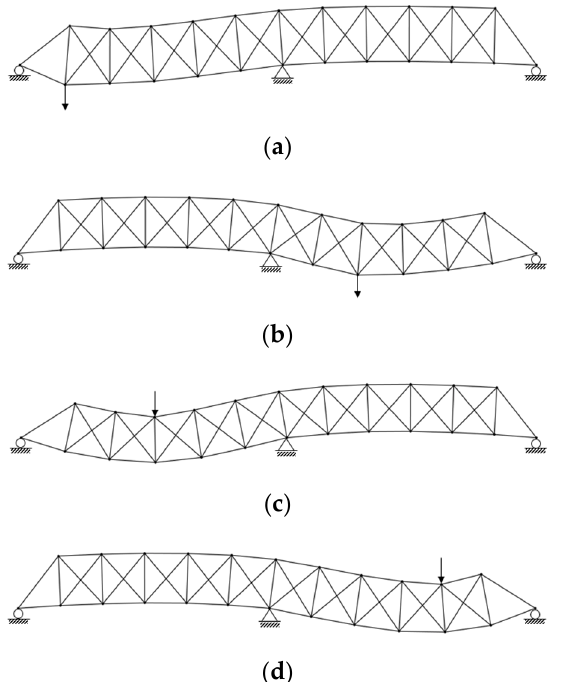
Figure 12. Examples of SSF derived by static analysis (truss): ( a ) SSF1, ( b ) SSF7, ( c ) SSF13, ( d ) SSF20. Table 3. Sensor location in the FEM model used for estimation (truss).